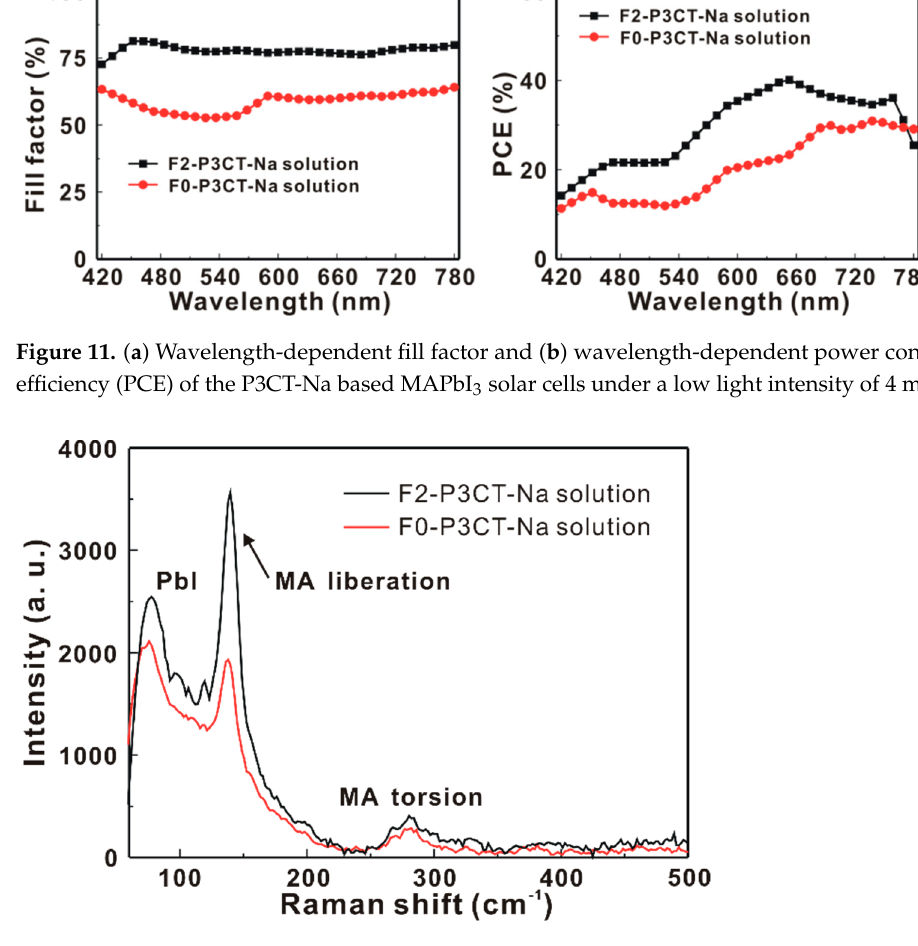
Figure 12. Raman scattering spectra from the MAPbI 3 /P3CT-Na interface under a green laser exci- tation with an objective lens (50×).